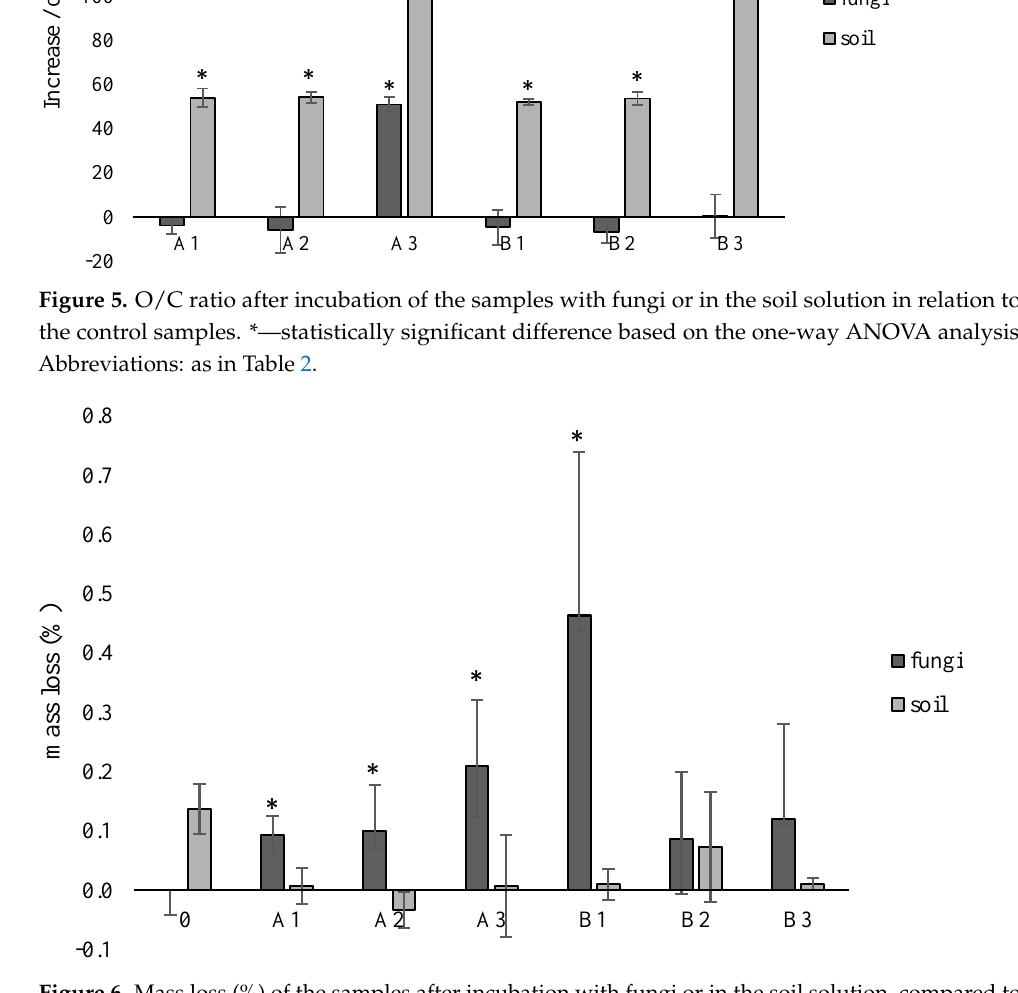
the control samples. * — statistically significant difference based on the one-way ANOVA analysis.